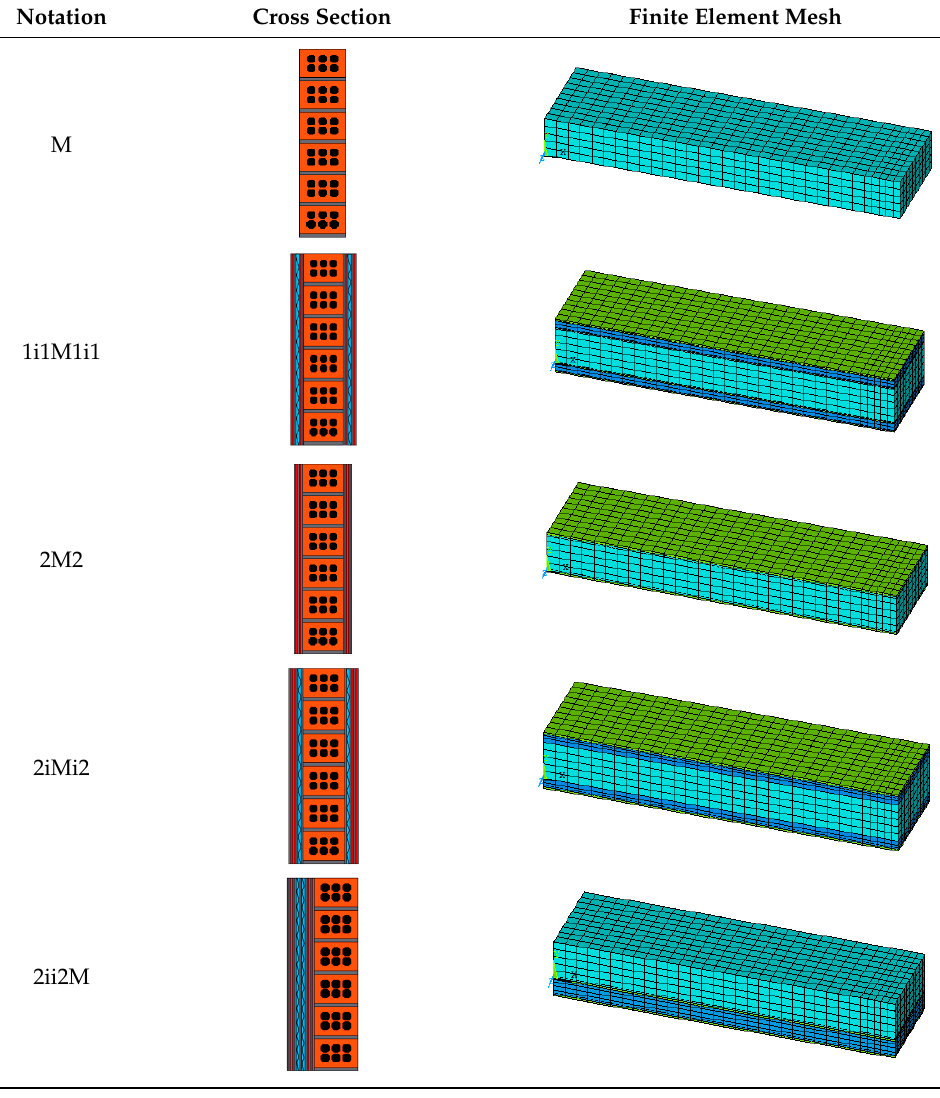
numbers of layers and thicknesses according to each experimental group case.